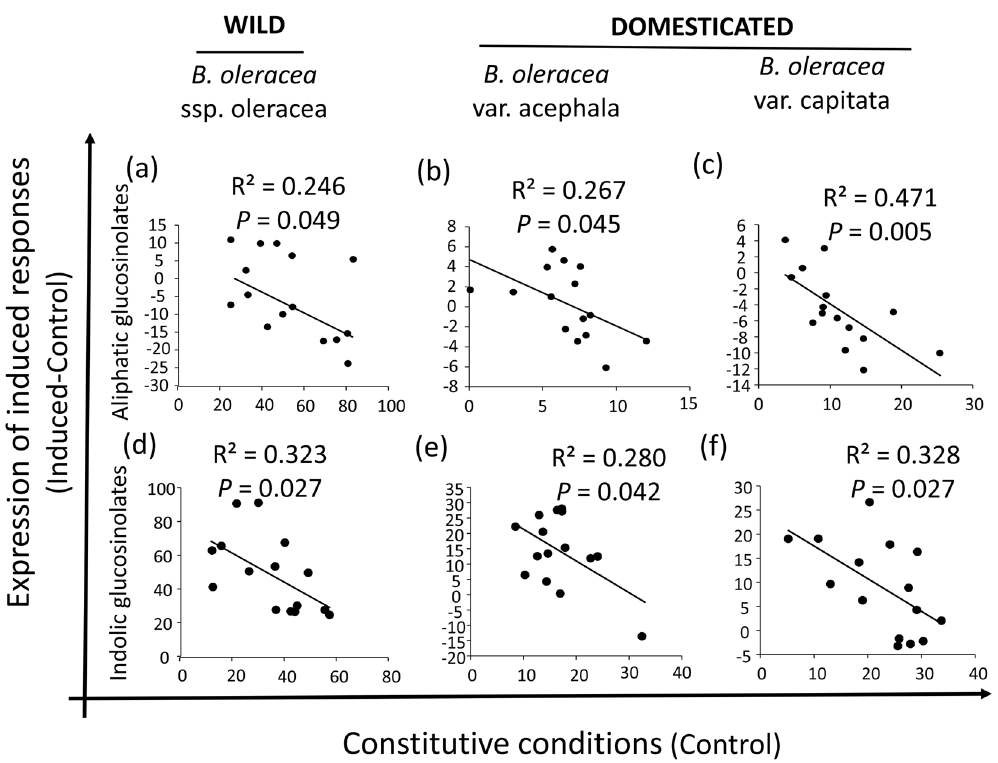
Figure 4. Correlations between constitutive glucosinolates and their inducibility. Genetic correlations between leaf constitutive concentrations (in µ mol g − 1 d.w.) of ( a – c ) aliphatic glucosinolates and ( d – f ) indolic glucosinolates and their corresponding inducibility by Mamestra brassicae damage in wild cabbage ( Brassica oleracea ssp . oleracea ) and two domesticated varieties of this species ( B . oleracea var . acephala and B . oleracea var . capitata ). Inducibility was measured as the genetic mean values in induced minus control plants. Negative significant correlations denote a genetic trade-off between constitutive and induced defences. R 2 coefficients and P -values are shown. Each point represent a genotype (N = 15